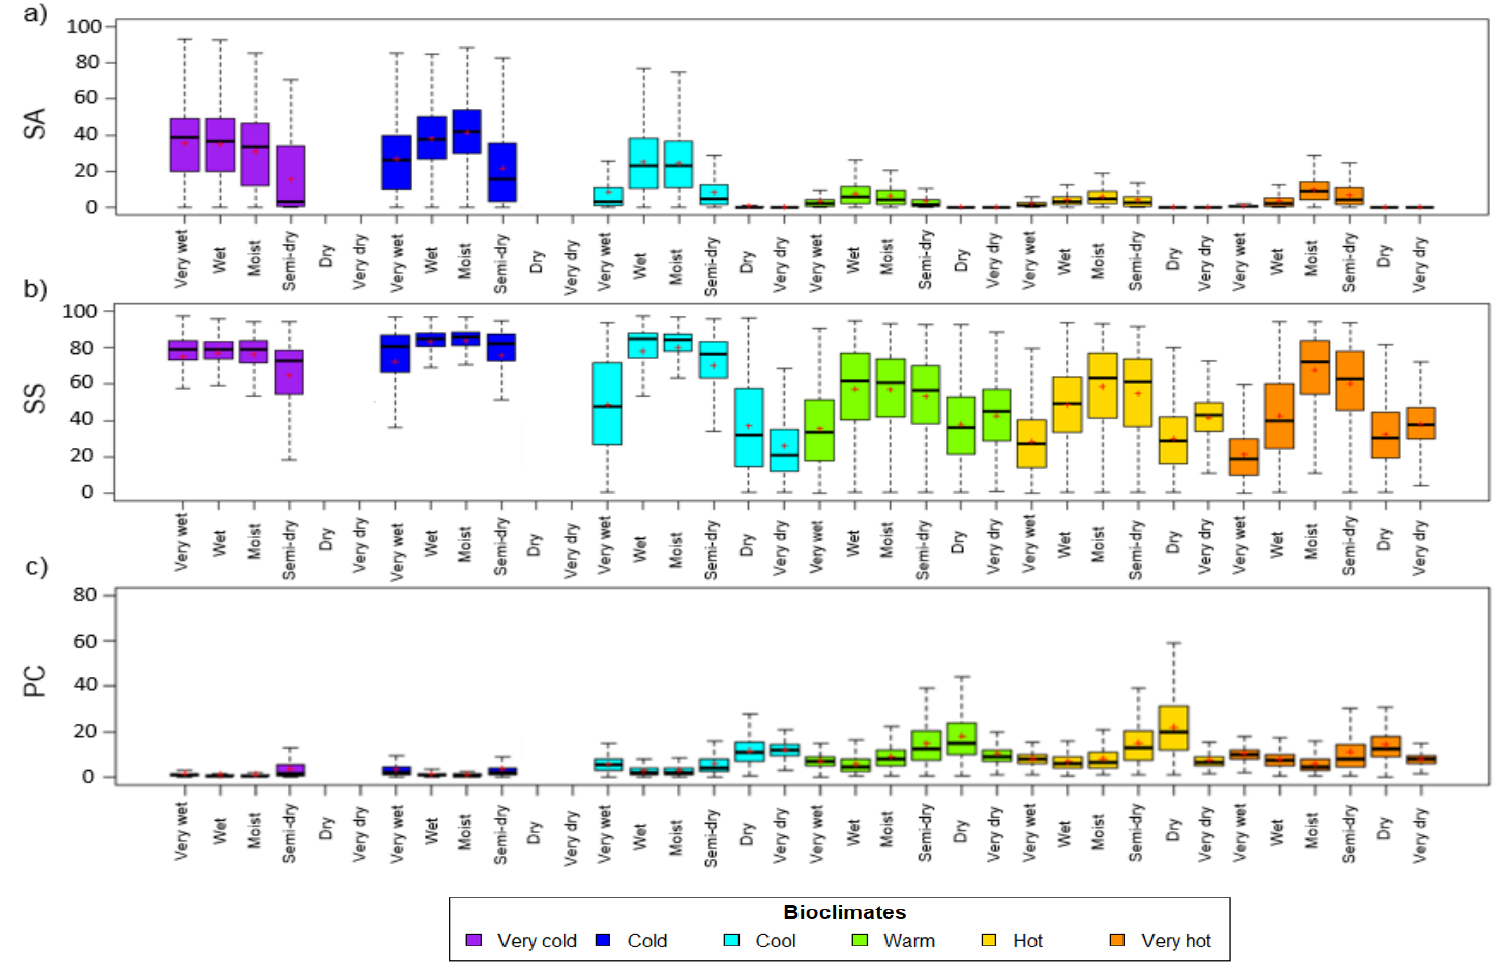
Figure 4. ( a ) Boxplots of the seasonality amplitude, ( b ) seasonality stability ( c ) and the pluri-annual cycles indicator of ecosystems with unimodal seasonal pattern per each bioclimate.